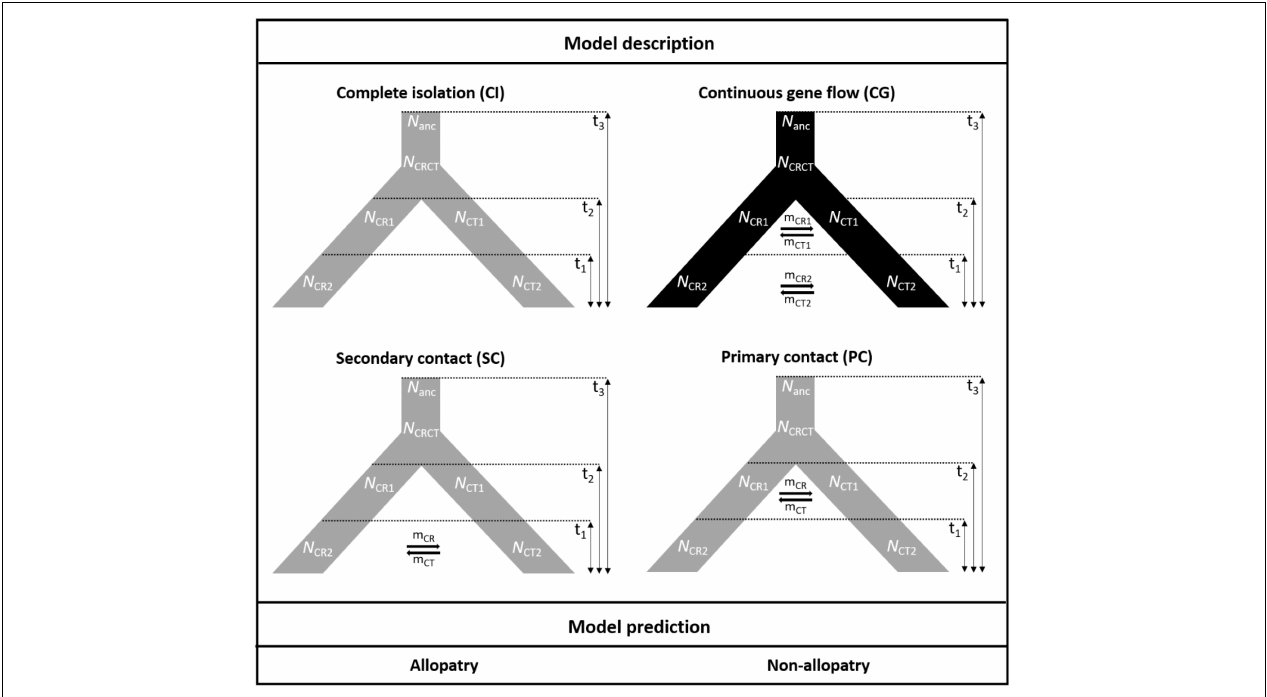
FIGURE 3 | The four speciation models testing the demography and gene flow patterns in the approximate Bayesian computation models. The parameters are defined in Table 1